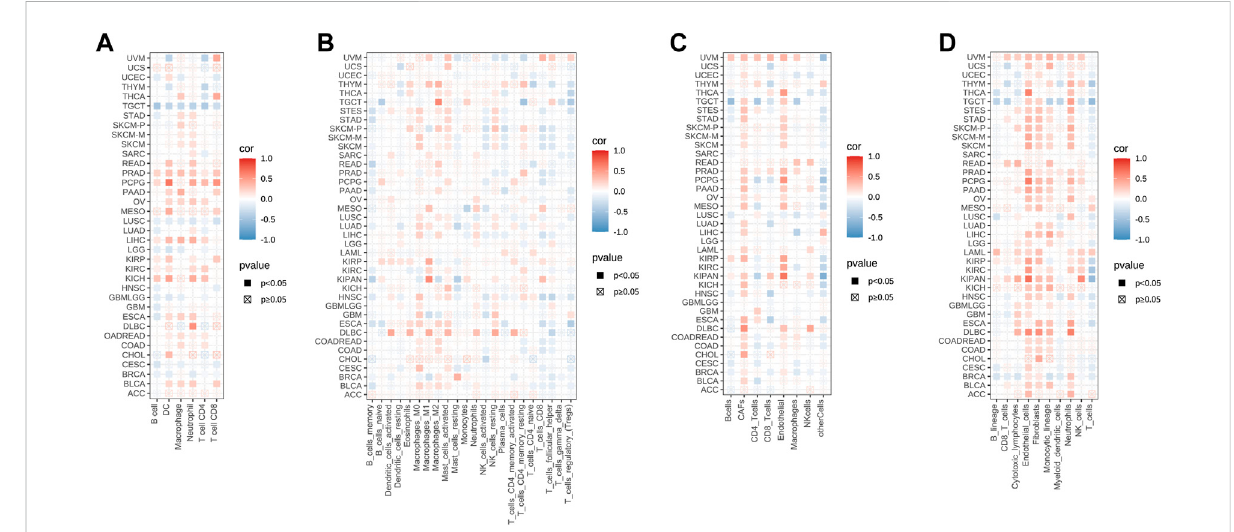
FIGURE 7 STC2 expression correlated with immune in fi ltration. (A) TIMER analysis showing the correlation between STC2 expression and immune cells in fi ltration; (B) CIBERSORT showing the correlation between STC2 expression and immune cells in fi ltration; (C) EPIC showing the correlation between STC2 expression and immune cells in fi ltration; (D) MCPcounter showing the correlation between STC2 expression and immune cells in fi